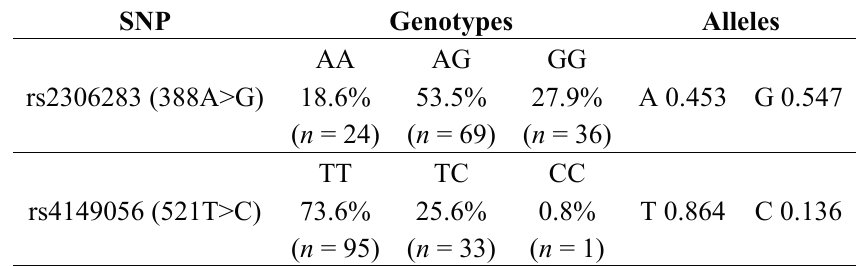
Table 3. Genotype distribution and relative allele frequencies of the studied single nucleotide